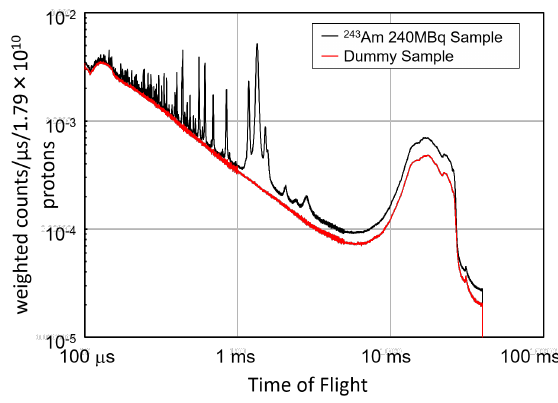
Figure 4. Weighted TOF spectra of the 243 Am and dummy sam-